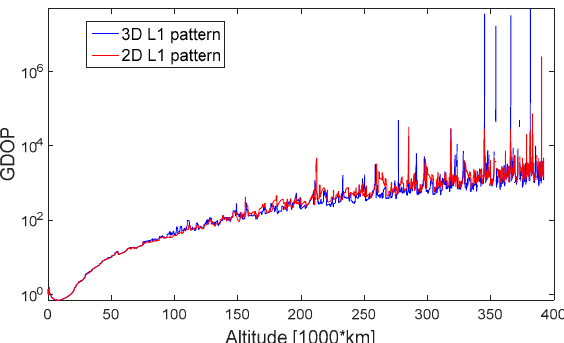
Figure 12. Geometric dilution of precision (GDOP) in log scale during the assumed MTO.